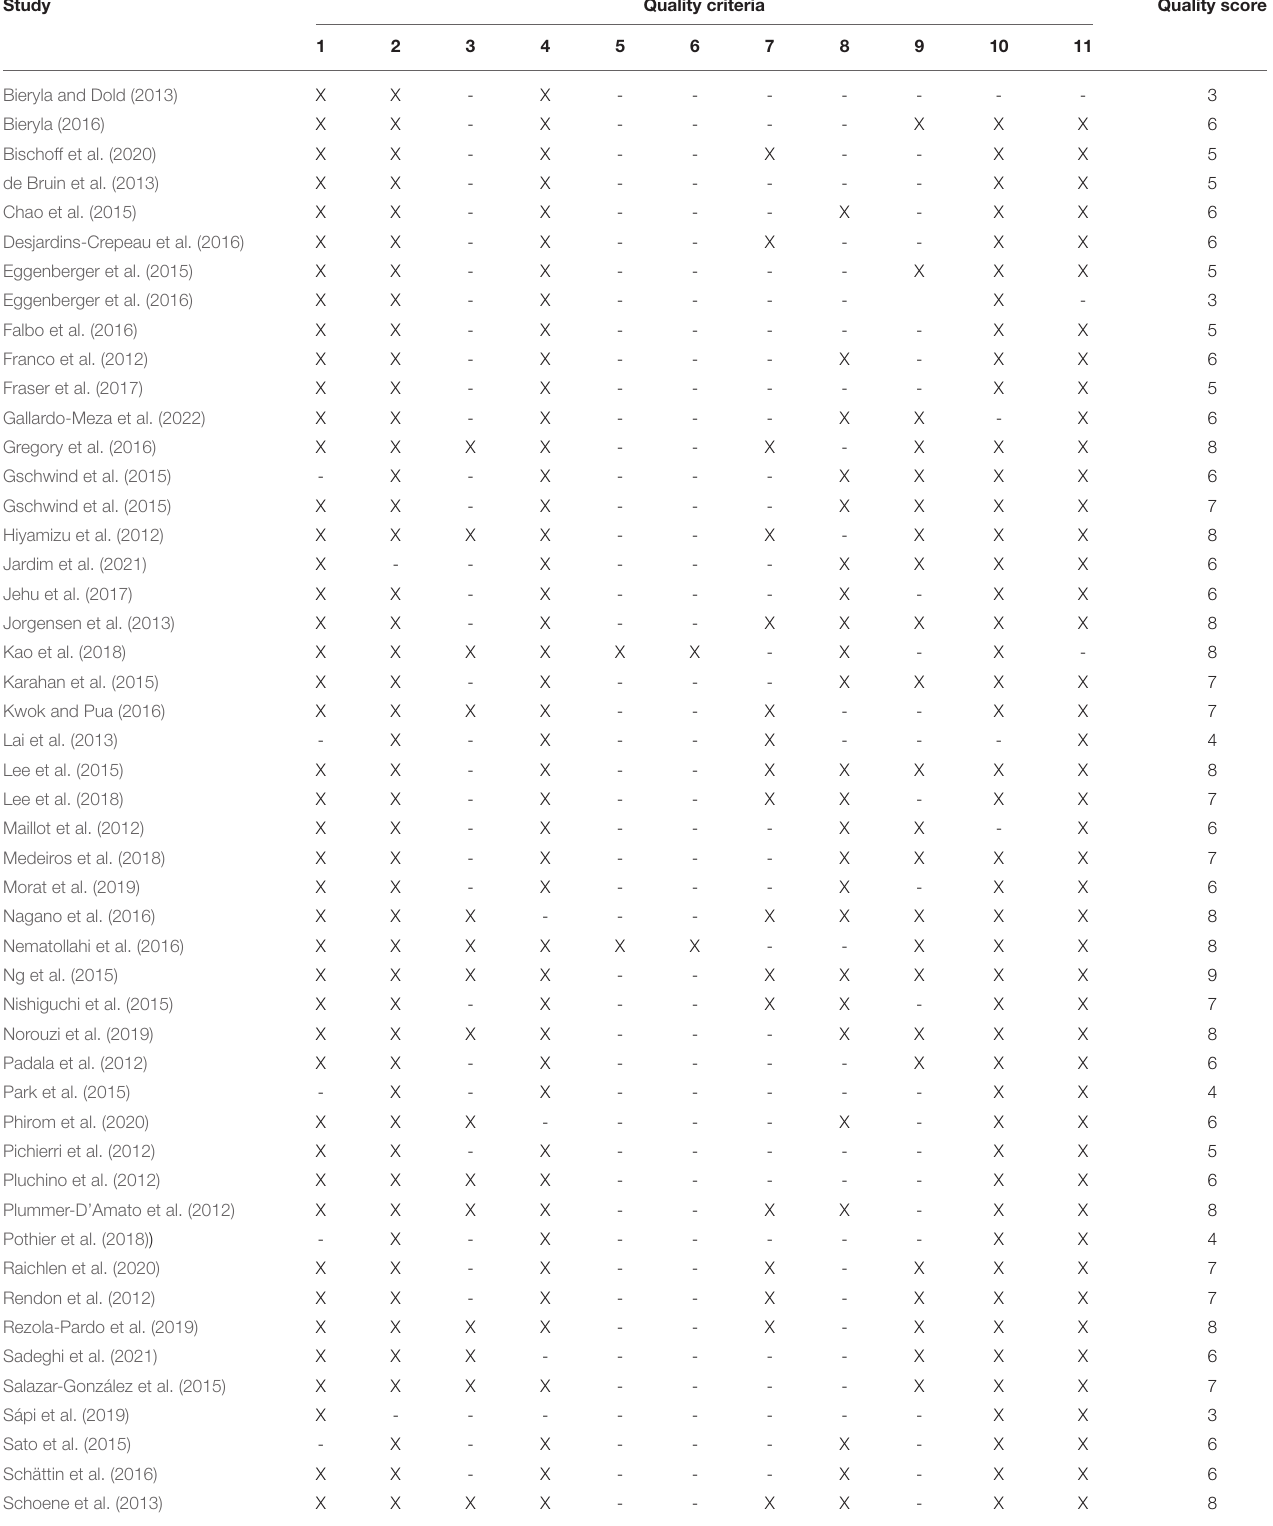
TABLE 2 | Quality assessment of included studies with healthy older adults according to PEDro scale.